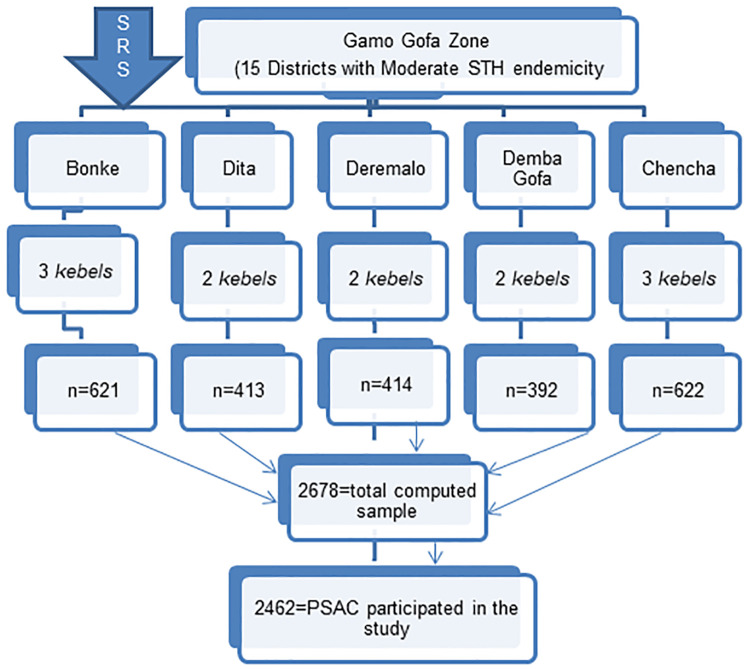
Sampling profile.